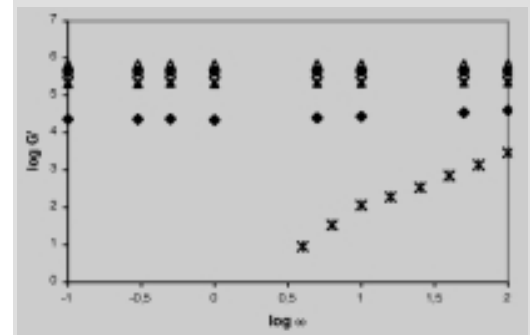
Figure 1 (left above): Master curves of AcA2 ( Ï ) and GMA2 ( Ê ) at a reference temperature of 30 °C. Data obtained at 150°C: AcA2 ( Ì ), GMA2 ( Á ). Figure 2 (right above): Stor- age modulus versus fre- quency for blend a2g2m15 at 150 °C as a function of the reaction time ( Ï : 1240s , · : 1840 s, Ú : 2440 s, Ì : 3040 s, Ê : 4240 s, Û : 6640 s). Stor- age modulus versus fre- quency for the pure compo- nent AcA2 at the same temperature. Figure 3 (left below): Stor- age modulus versus reaction time for symmetric blends at 180°C ( Ï : a2g2m15, ‚ : a5g5m20, Ú :